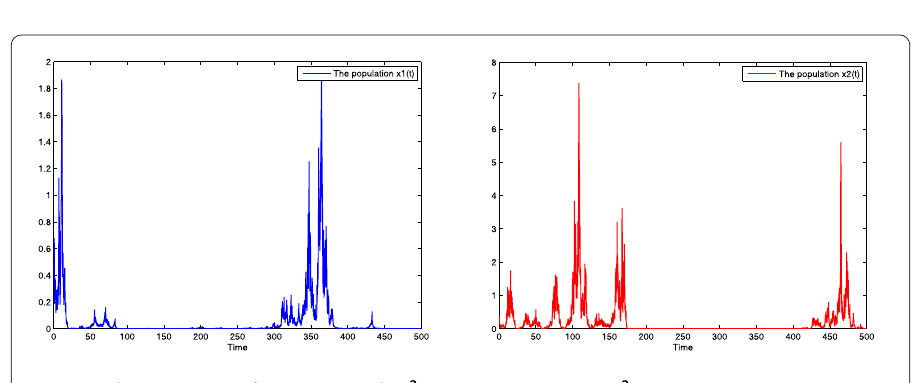
( t ) = 0.32 + 0.04sin( t ), σ 2 1